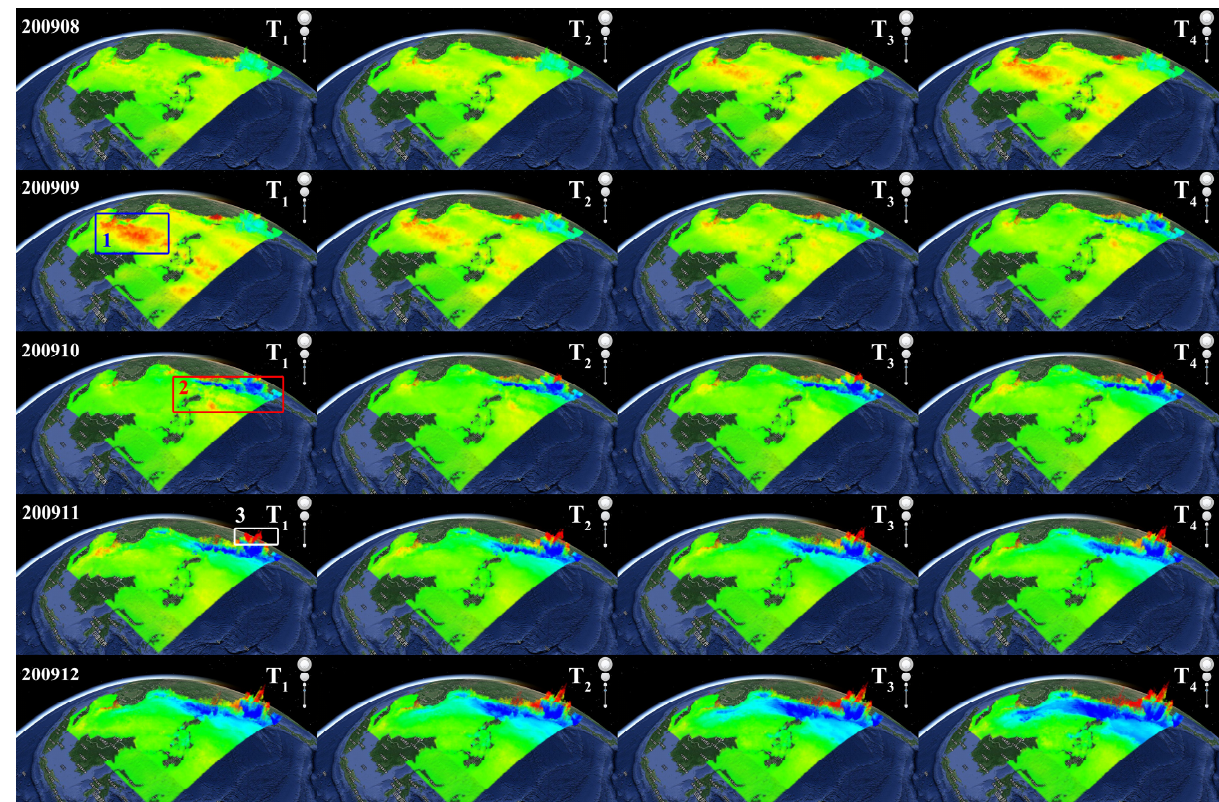
Figure 14. Air-sea CO 2 flux dynamic simulation over time represented by interactive volume rendering with real-time spatiotemporal